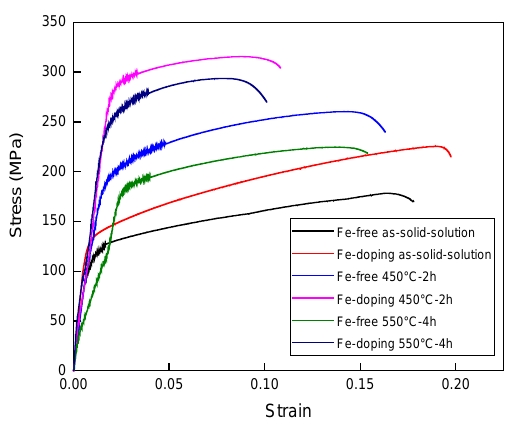
Figure 8. Stress–strain curves of as-solid-solution and ageing-treated, Fe-free and Fe-doping alloys. Table 2. The strength and elongation of Fe-free and Fe-doping alloys. Tensile Strength (MPa) Yield Strength (MPa) Elongation (%) As-solid-solution 180.4 113.6 Fe-free alloy Fe-doping alloy